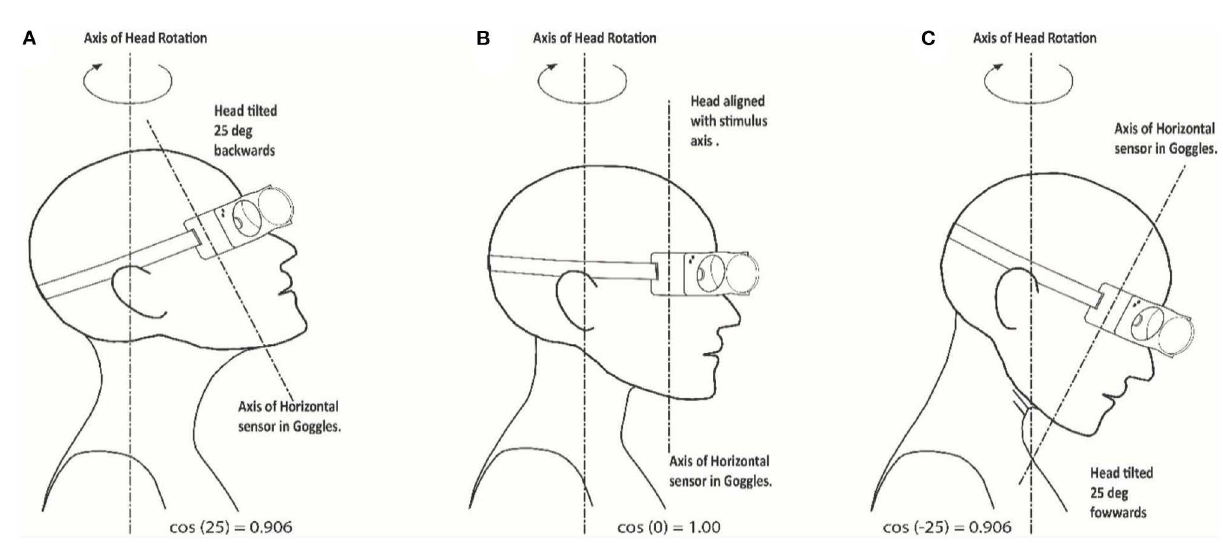
FIGURE6 Misalignment between head stimulus axis and tilted head/goggles axis: sketches indicating the axis orientations. (A) 25 deg upwards and backwards; (B) stimulus and head axes aligned; (C) 25 deg downwards and forward